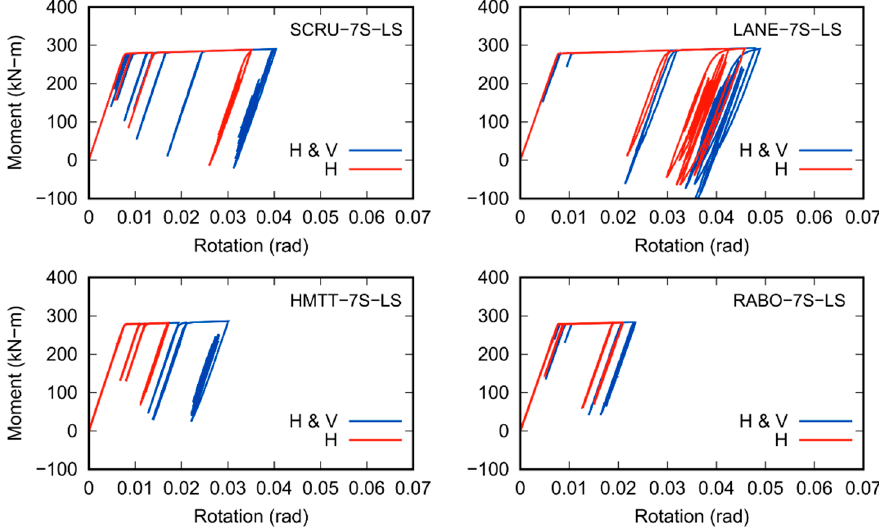
Figure 22. Non-linear response of the outer-most fiber in the considered beam for different earth- quakes; 8-story building (Part 2).